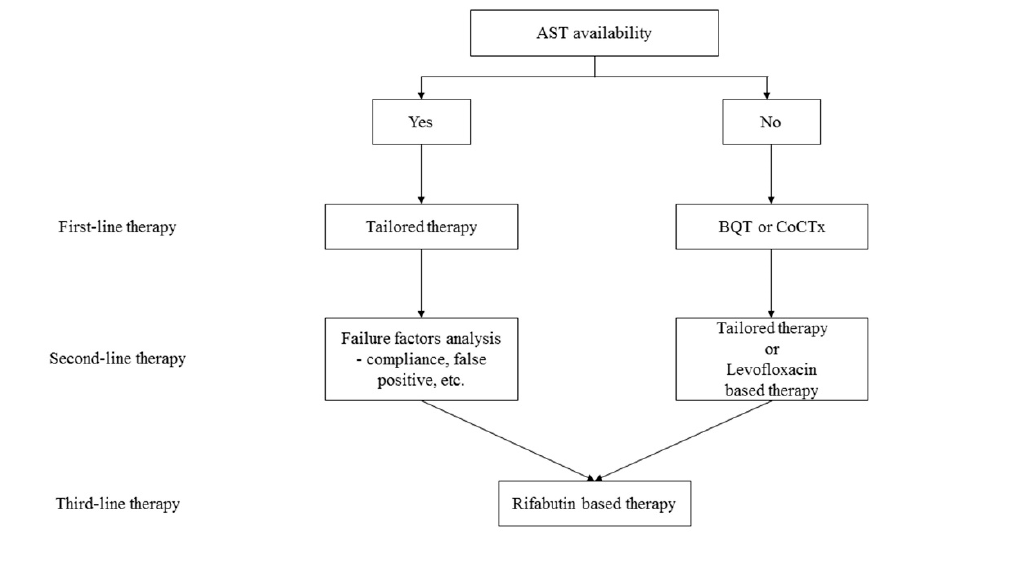
Figure 1. Simplified H. pylori treatment strategy. Table 1. Regimens for the treatment of Helicobacter pylori infection.